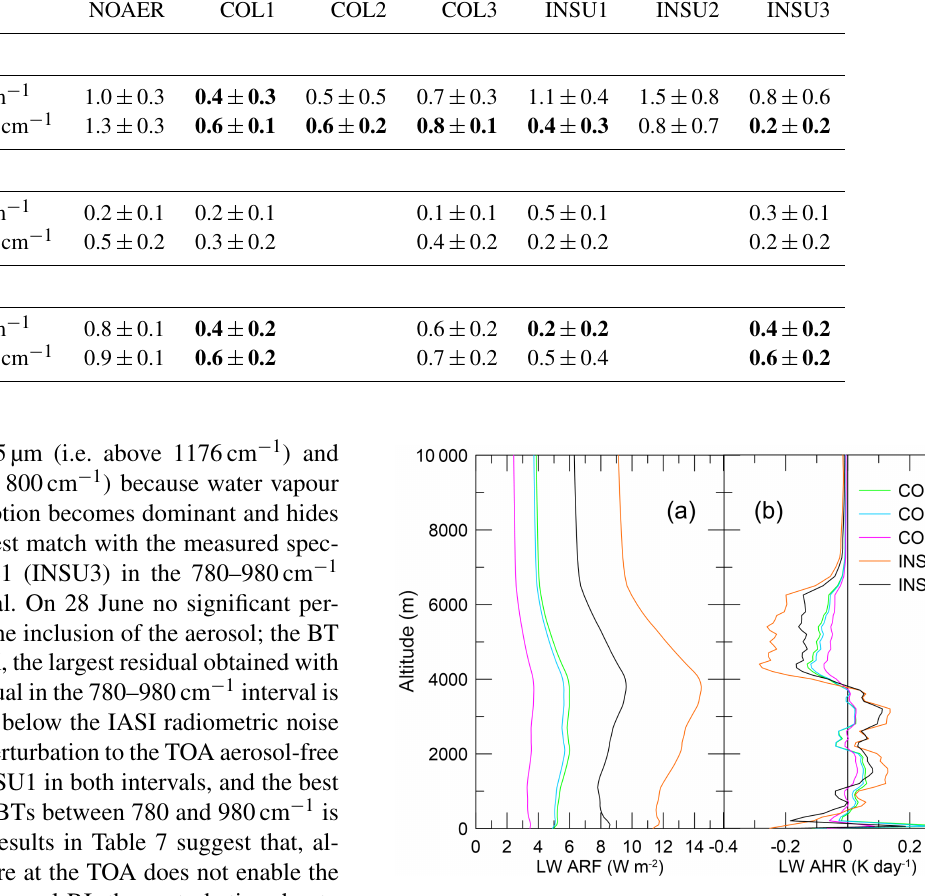
Figure 13. Dust LW radiative forcing (a) and heating rate (b) on 22 June calculated with different